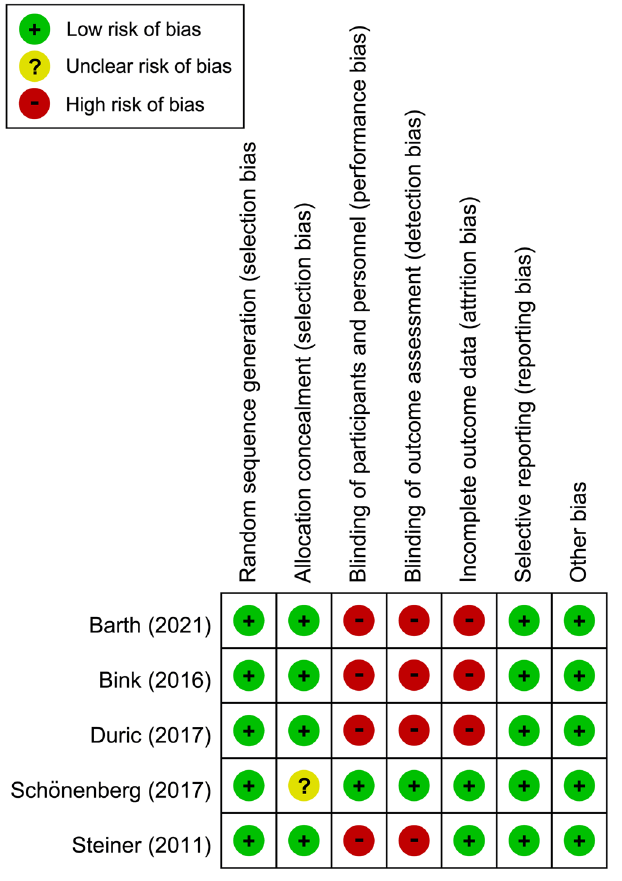
Figure 2. Risks of bias of individual studies.